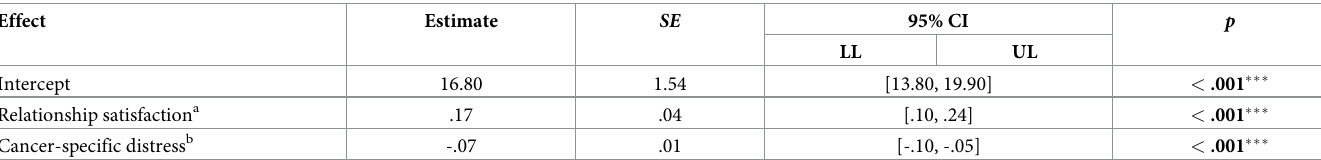
Table 3. Results of the stepwise regression analysis for self-acceptance in men ( n =